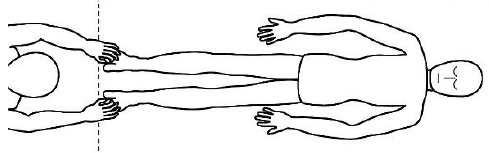
Figure 1. Resting state (task-free) supine position.